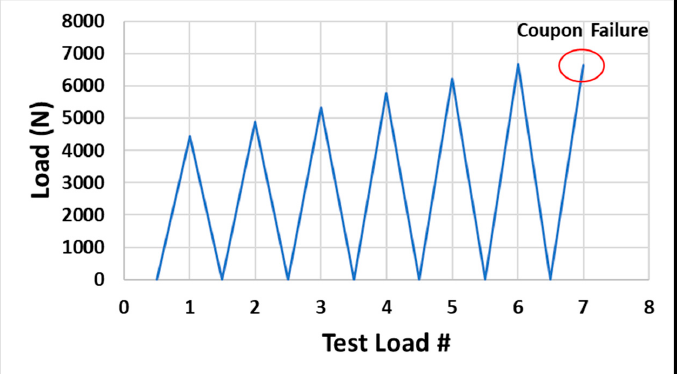
Figure 16. Example coupon (11) test loads.